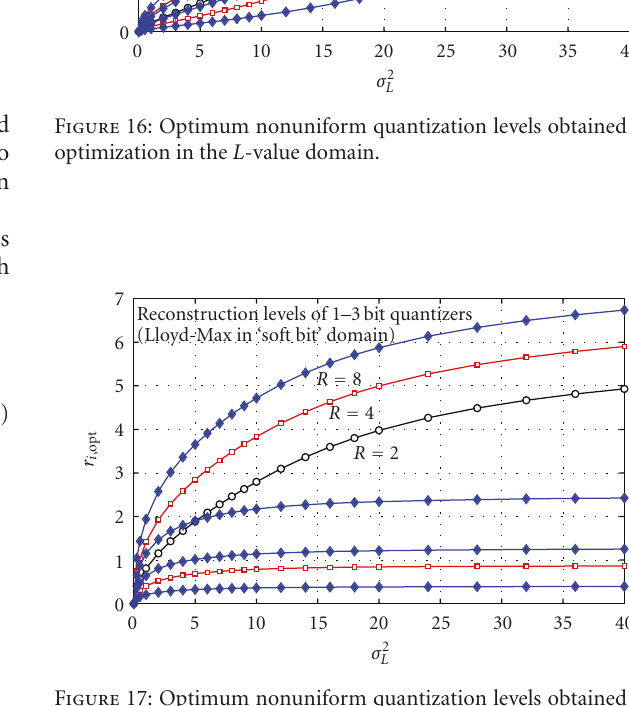
Figure 17: Optimum nonuniform quantization levels obtained by optimization in the “soft-bit” domain.